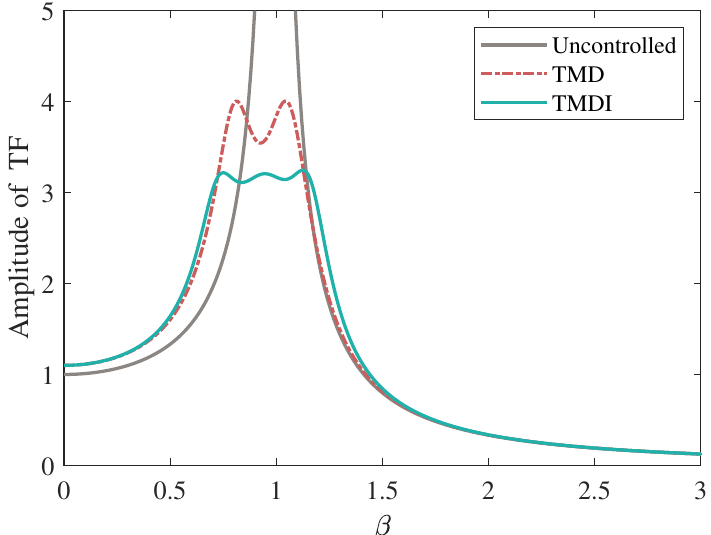
Figure 5. The TF amplitude of the structural displacement under different devices ( u t = 0.10).